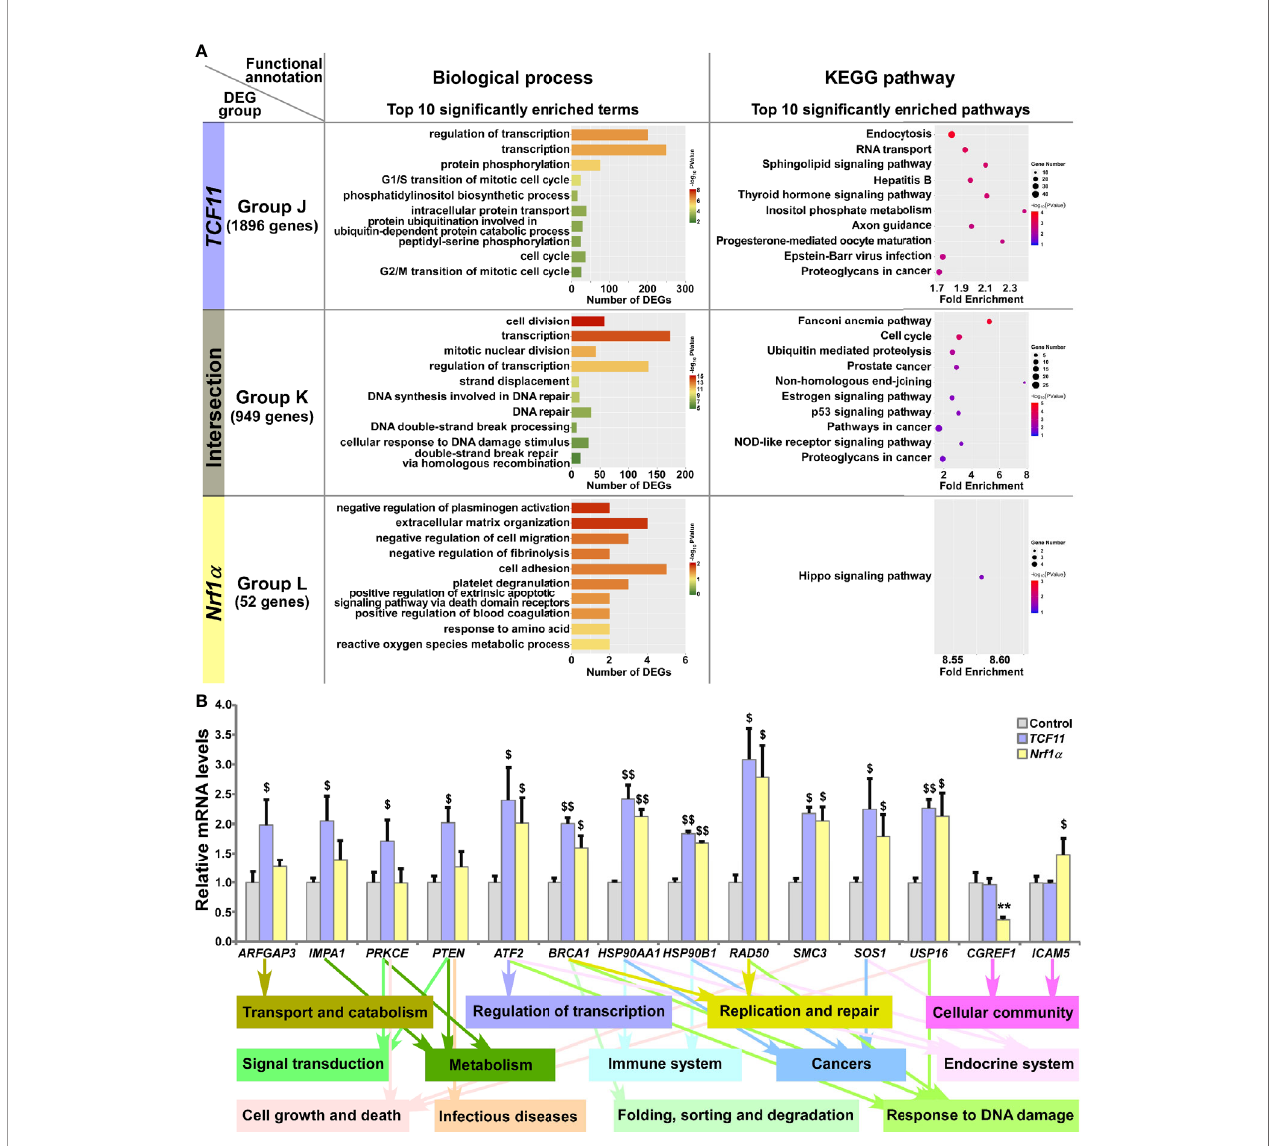
FIGURE 6 | Functional annotation of speci fi c or common DEGs in TCF11 and Nrf1 a cells. (A) Top 10 of signi fi cant biological process terms and pathways enriched by DEGs in Groups J, K, and L were exhibited in histograms and scatterplots, respectively. (B) After induced with 1 m g/ml Tet for 12 h, total RNAs were isolated from Control, TCF11 or Nrf1 a cell lines and then reversely transcribed into the fi rst strand of cDNA. Subsequently, relevant mRNA levels of DEGs that were associated with more functions as annotated, along with high expression levels and well signi fi cance in Groups J to L, were determined by quantitative real-time PCR in Control, TCF11 and Nrf1 a cells. The data are shown as mean ± SEM (n = 3 × 3, ** p < 0.01; $ p < 0.05; $$ p < 0.01, when compared to the Control values